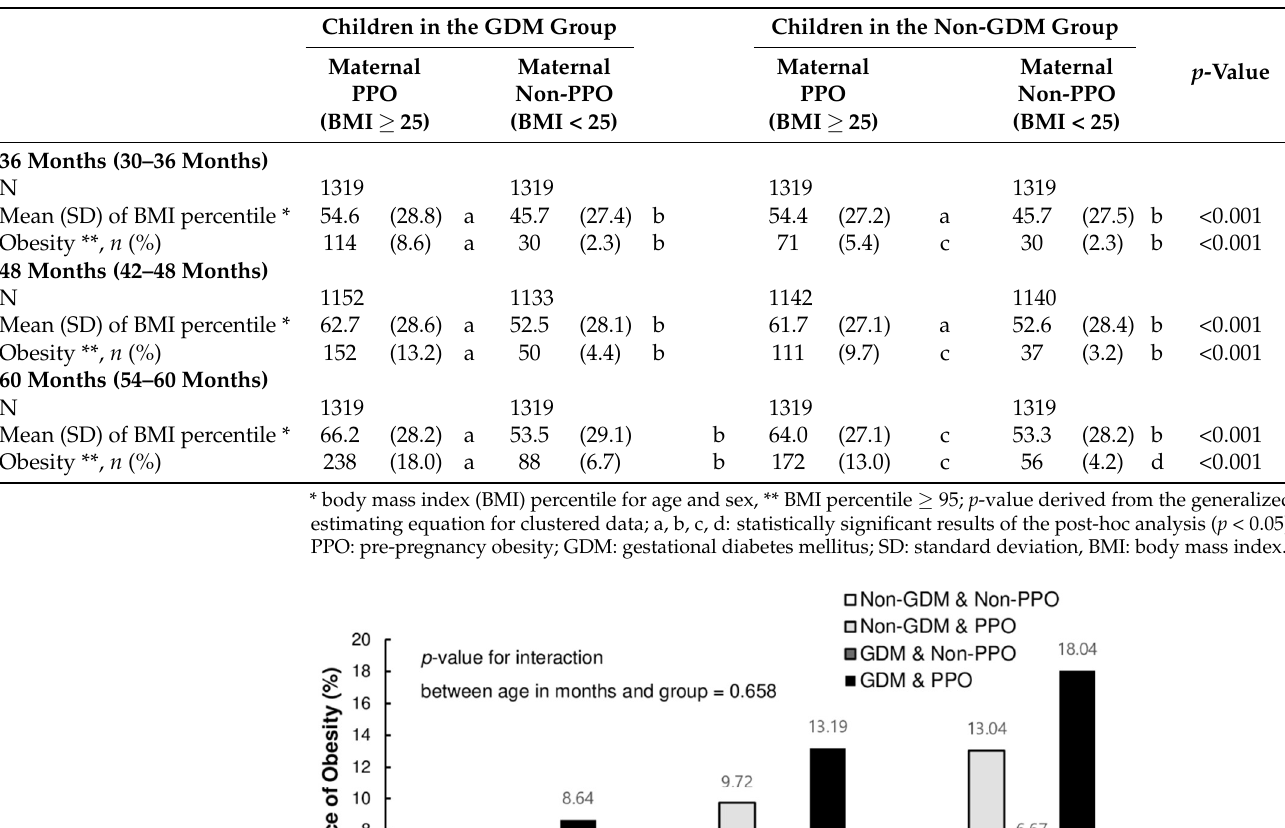
Table 2. Distribution of BMI percentile and prevalence of obesity according to maternal GDM and PPO.